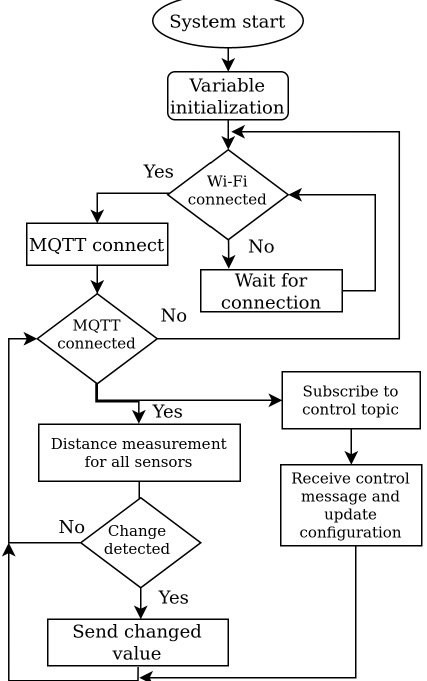
Figure 6. IoT node algorithm